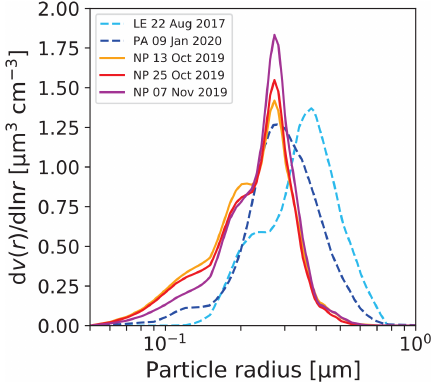
Figure 16. Volume size distributions of the stratospheric smoke particles retrieved from the multiwavelength lidar observations on 13 and 25 October and 7 November 2019. A narrow accumulation mode with particle sizes (diameters) from 400 to 1000nm and a weak Aitken mode to the left is typical for aged wildfire smoke par- ticles. For comparison, the size distribution of Australian wildfire smoke particles measured over Punta Arenas, Chile (PA; dark blue) and of Canadian smoke measured over Leipzig, Germany (LE; light blue) are presented as well. All size distributions are normalized so that the integral over each distribution is 1.